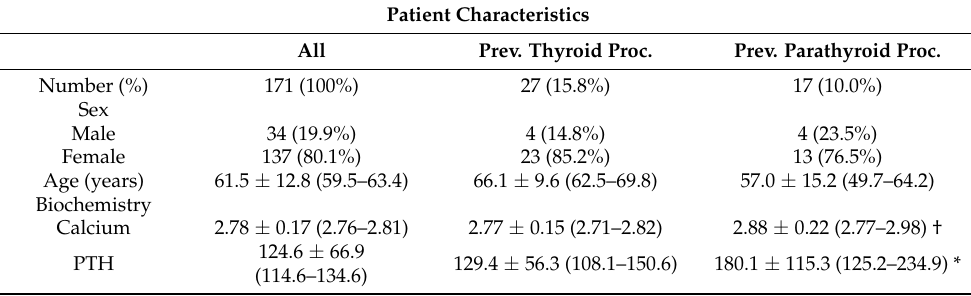
Table 1. Patients characteristics of 171 FEC-PET-CT&4D-CT from July 2017 to June 2020 for all patients and the two subgroups with previous thyroid and parathyroid surgery. Qualitative data are expressed as numbers; continuous data are expressed as mean ± SD and 95% confidence interval.